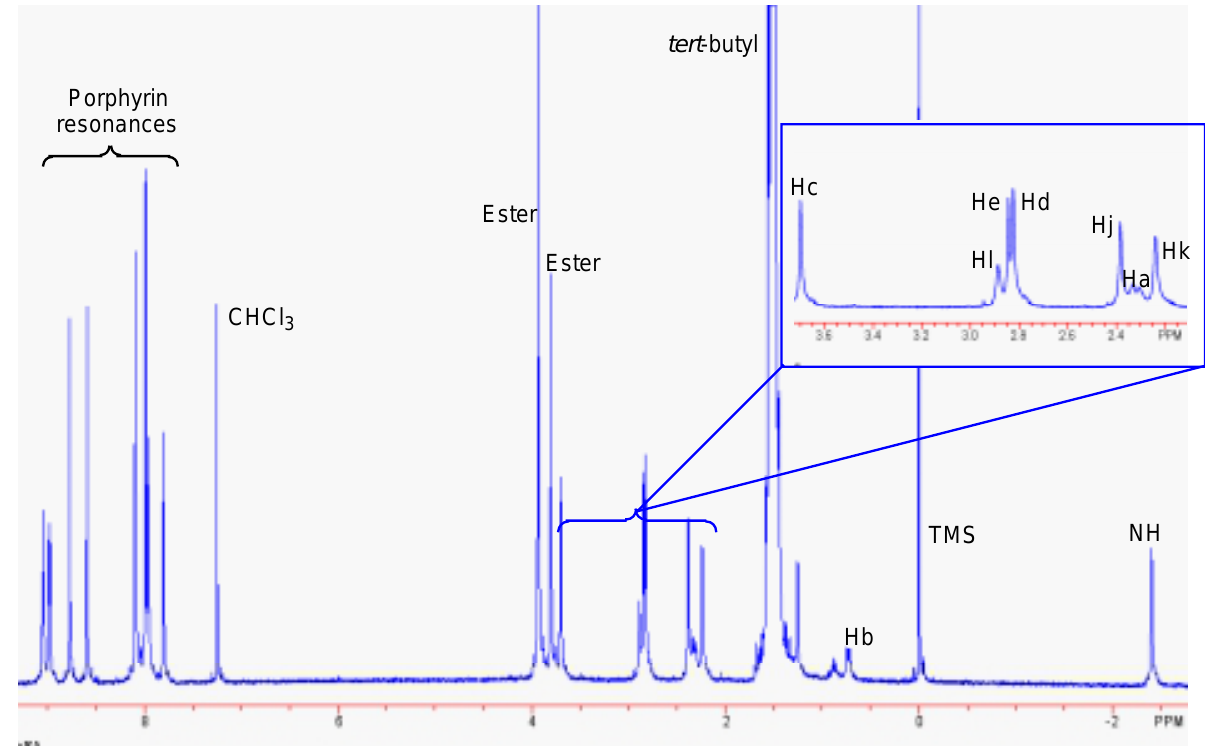
) of bis -porphyrin cavity 14 3